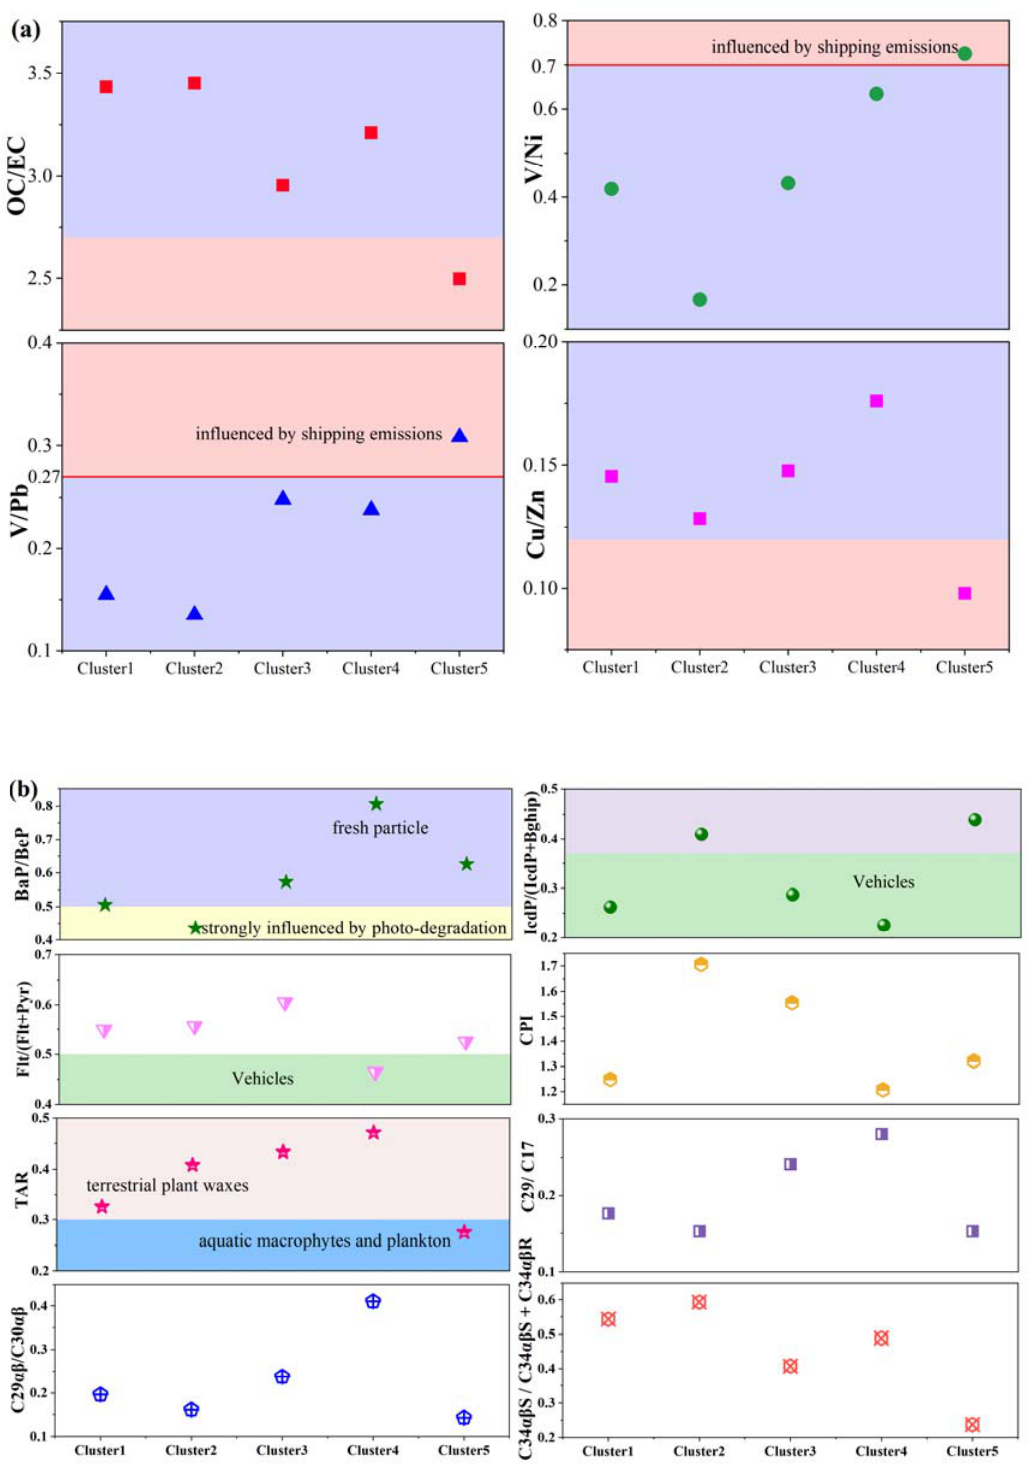
Figure 4. Diagnostic ratios of ( a ) OC/EC, V/Ni, V/Pb, and Cu/Zn for the five clusters, ( b ) the CPI, the PAH congener diagnostic ratios (Flt/(Flt + Pyr), BaP/BeP, IcdP/(IcdP + Bghip)), the ratio of C29/C17 and the terrigenous to aquatic ratio (TAR), and the ratio of HP29/HP30 and 22S/22S + 22R for the five clusters.